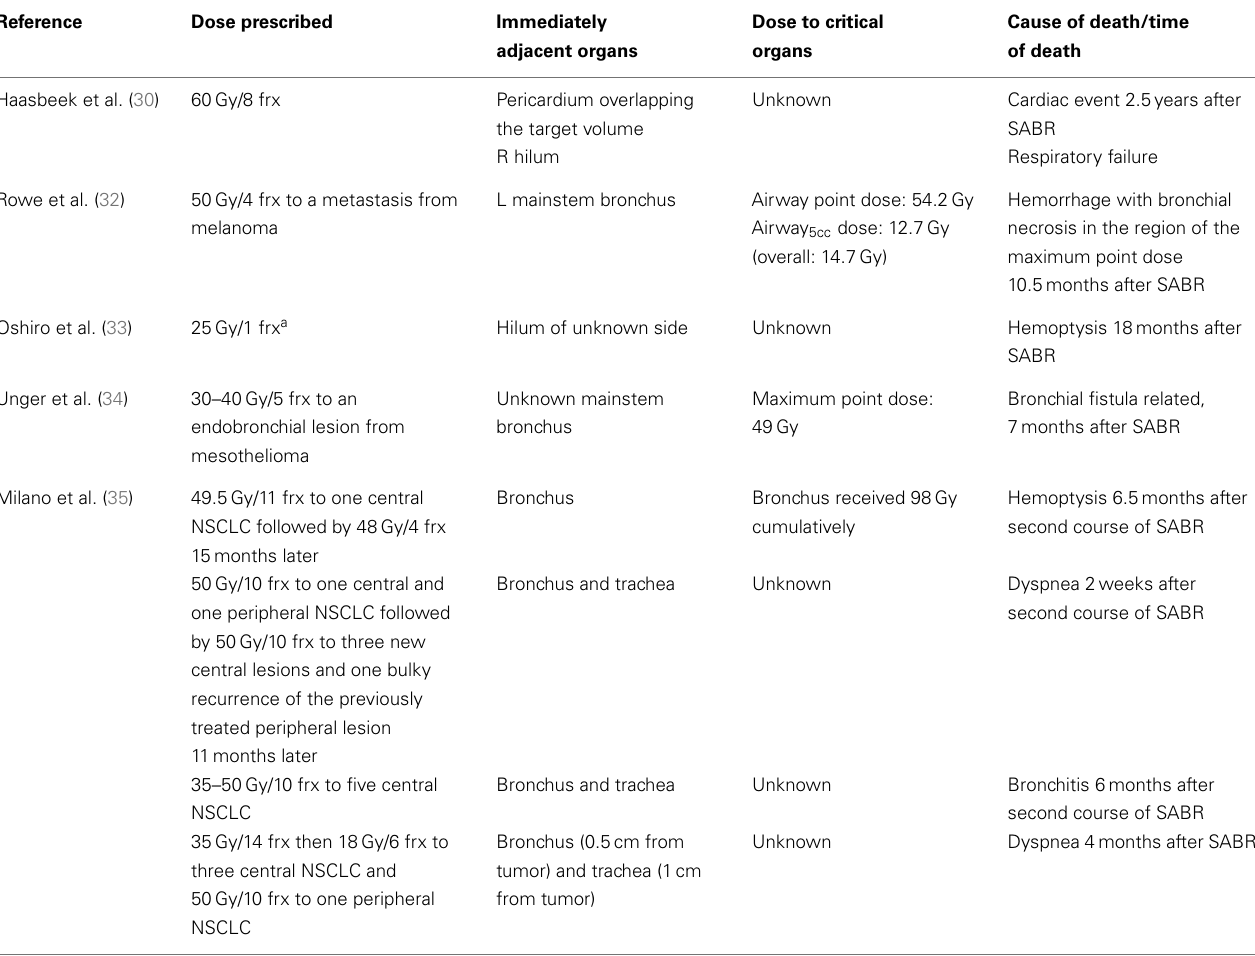
Table 3 | Deaths reported in studies on SABR for central lung tumors only